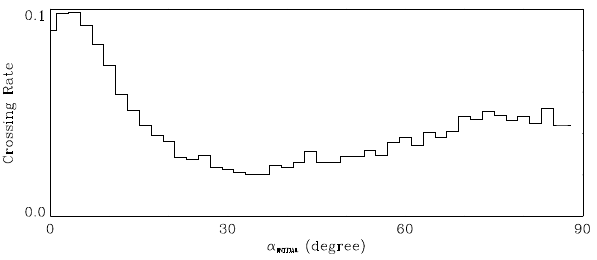
Fig. 7. Number of particles crossing the MP depending on final pitch-angle at the observation point. The four curves correspond to the initial pitch-angles that are